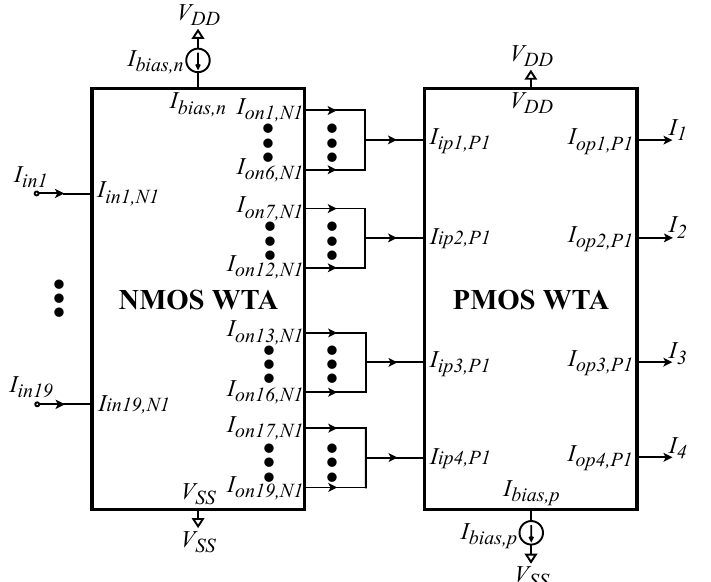
Figure 6. The utilized WTA circuit is composed of a 19-neuron WTA and a 4-neuron WTA circuit connected sequentially. The output currents of the first WTA circuit that correspond to the sub-classes of each class are summed and then inserted into the second WTA.